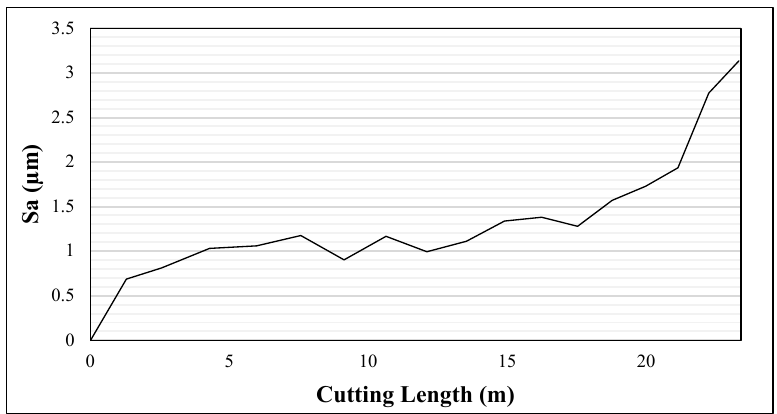
Figure 4. Tool wear evolution curve of the solid carbide end mill for 23.33 m of shoulder milling of AISI 5140 steel block.